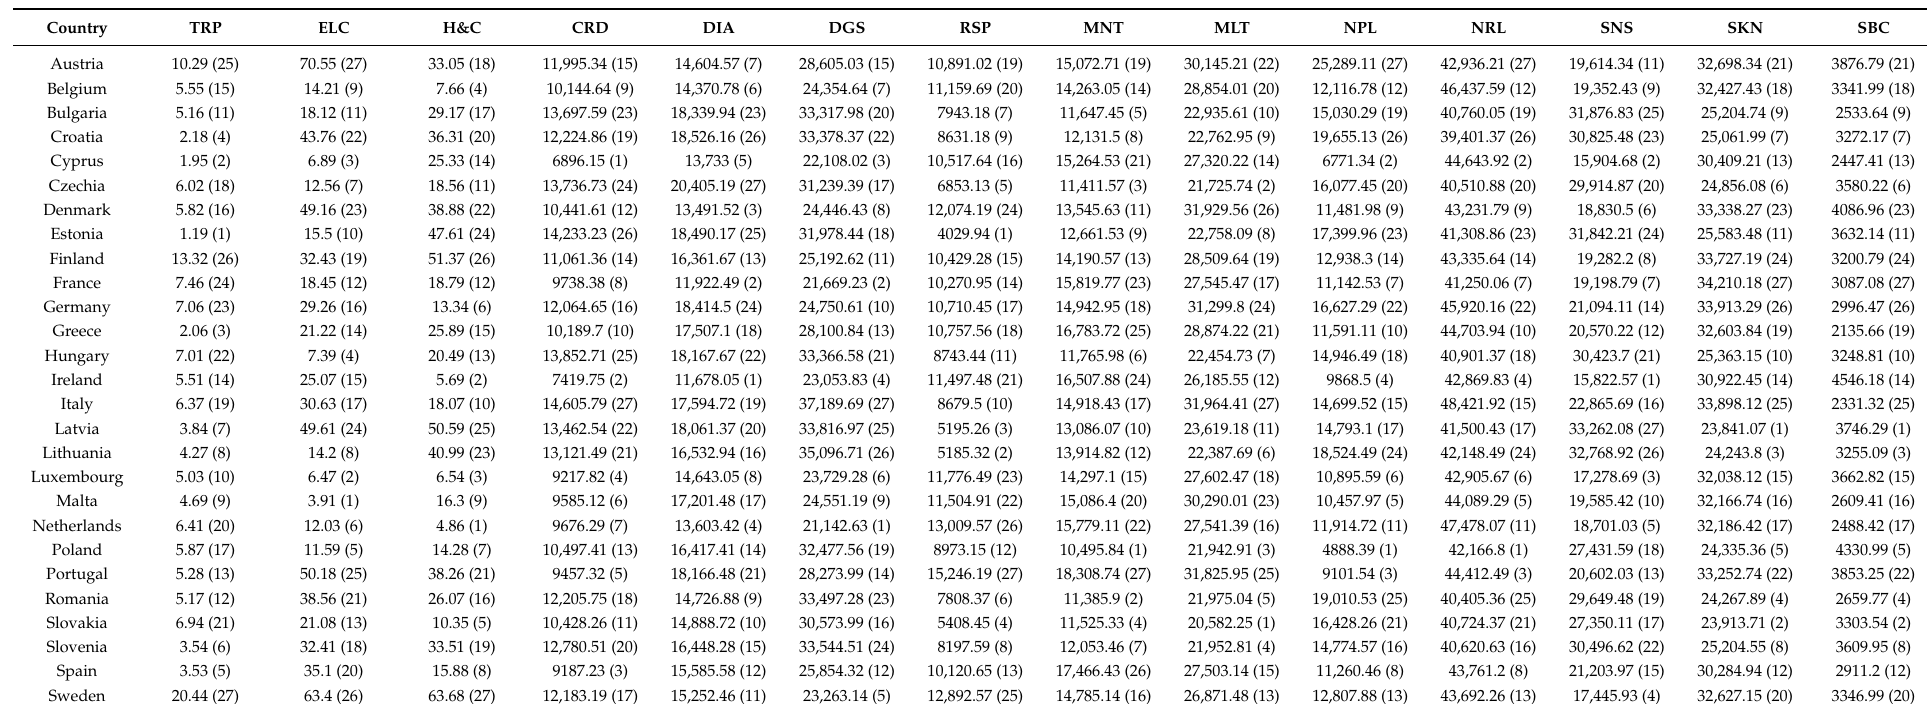
Table A1. Mean values of selected variables